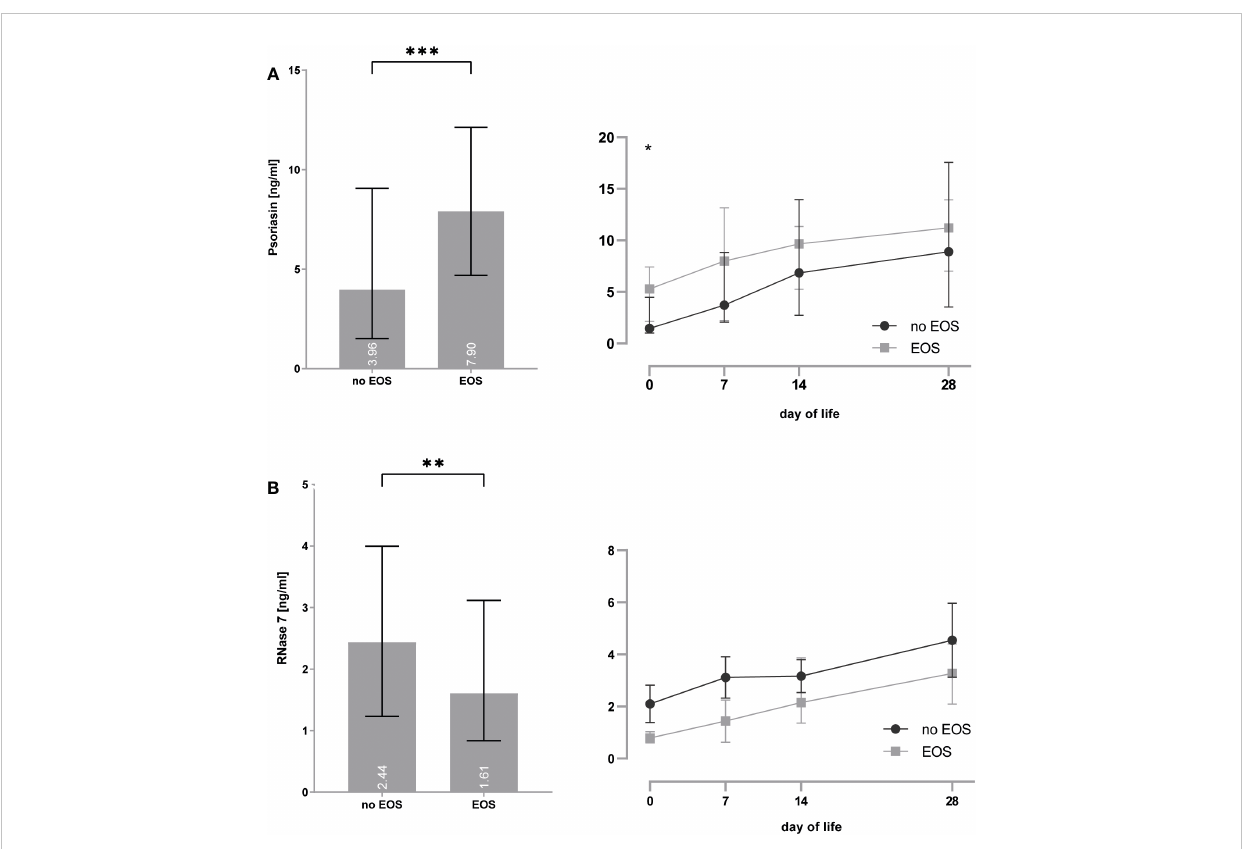
FIGURE 4 (A, B) Premature infants with clinical signs of early-onset sepsis (EOS) show increased concentrations of psoriasin (A) and decreased concentrations of RNase 7 (B) when compared to infants without signs of EOS. *p < 0.05, **p < 0.01, and ***p < 0.001 (Mann – Whitney U-test for left bar graphs, Kruskal – Wallis Test for right line diagram). Medians are given for each day in white numbers.Infants with LOS had increased expression of psoriasin [2.6 (1.5 – 6.5) vs. 7.4 (2.7 – 11.7), p < 0.0001], especially on day 7 [2.0 (1.3 – 3.6) vs. 7.6 (2.8 – 10.9), p = 0.008], but no differences in the concentrations of RNase 7 were found (see Figure